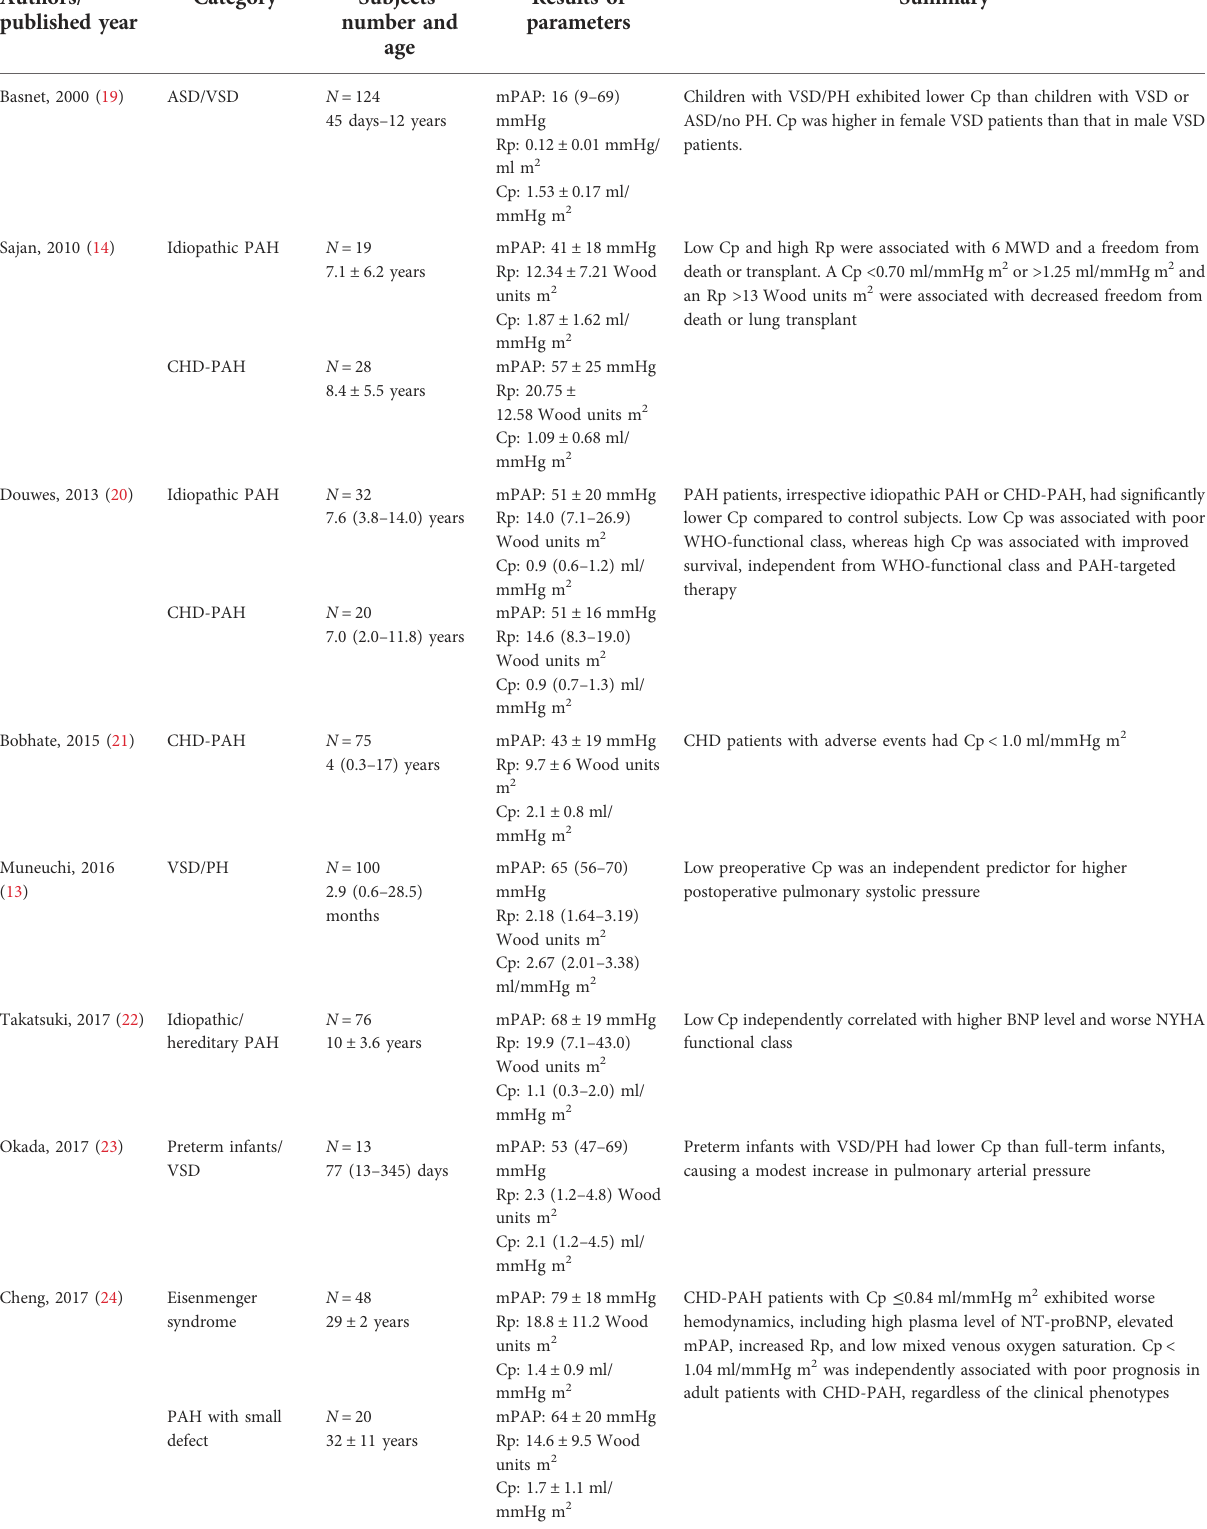
TABLE 2 List of the literature works regarding pulmonary vascular resistance and capacitance in patients with CHD-PH or children with idiopathic